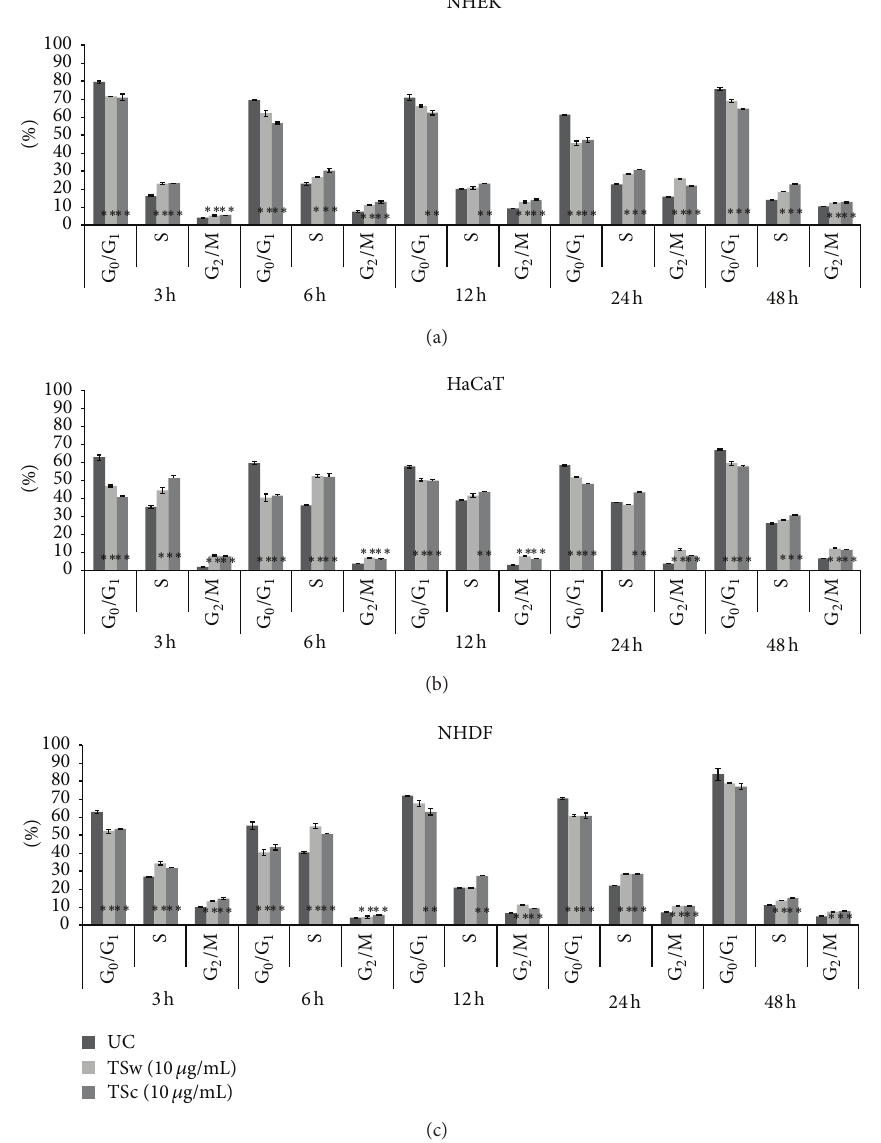
Figure 3: Flow cytometric analysis of cell cycle progression. The cells NHEK (a), HaCaT (b), and NHDF (c) were incubated with TSw, respectively, TSc from 3h to 48 h. The percentage of cells in entire cell cycle was considered as 100%, presented are mean values ± SD with 𝑛 = 2 replicates of two independent experiments; ∗ 𝑃 < 0.05 , ∗∗ 𝑃 < 0.01 compared to untreated cells. UC: untreated cells.